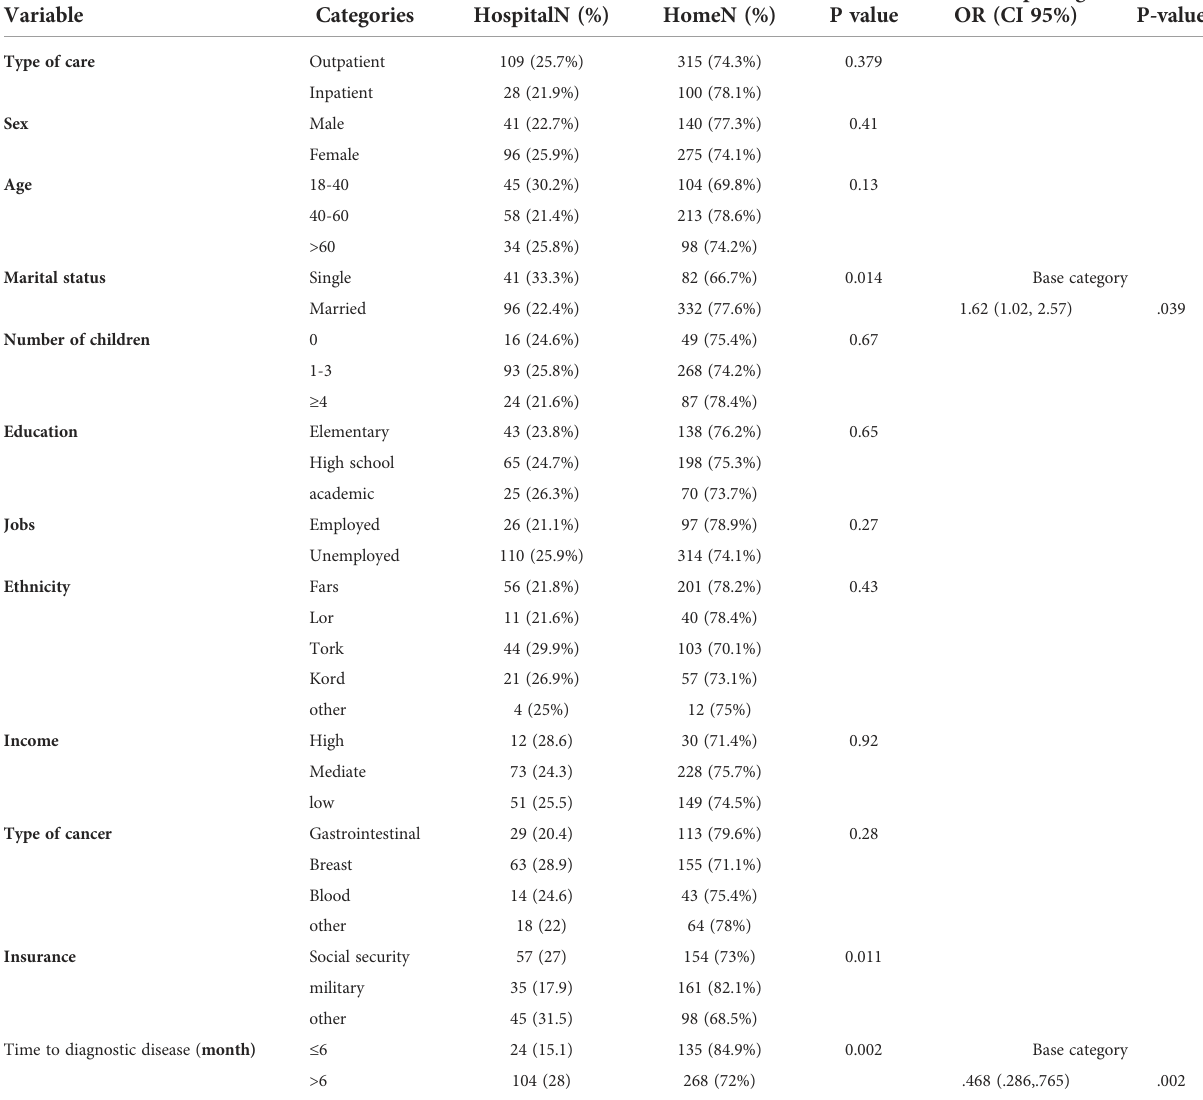
TABLE 3 Correlations between variables and the preferred place of death of cancer